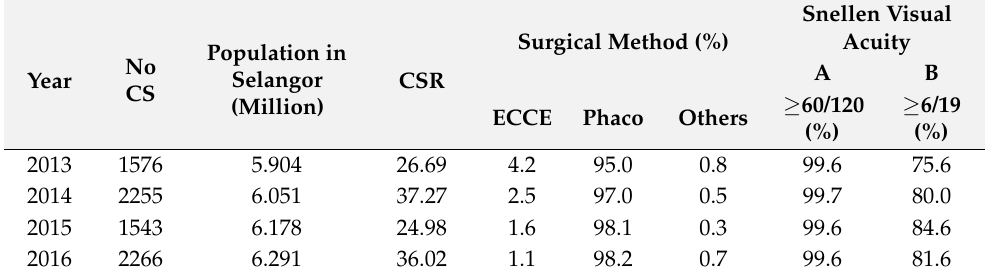
Table 2. Analysis of Cataract Surgeries in Cataract Operation Centre, MAIWP-Hospital Selayang